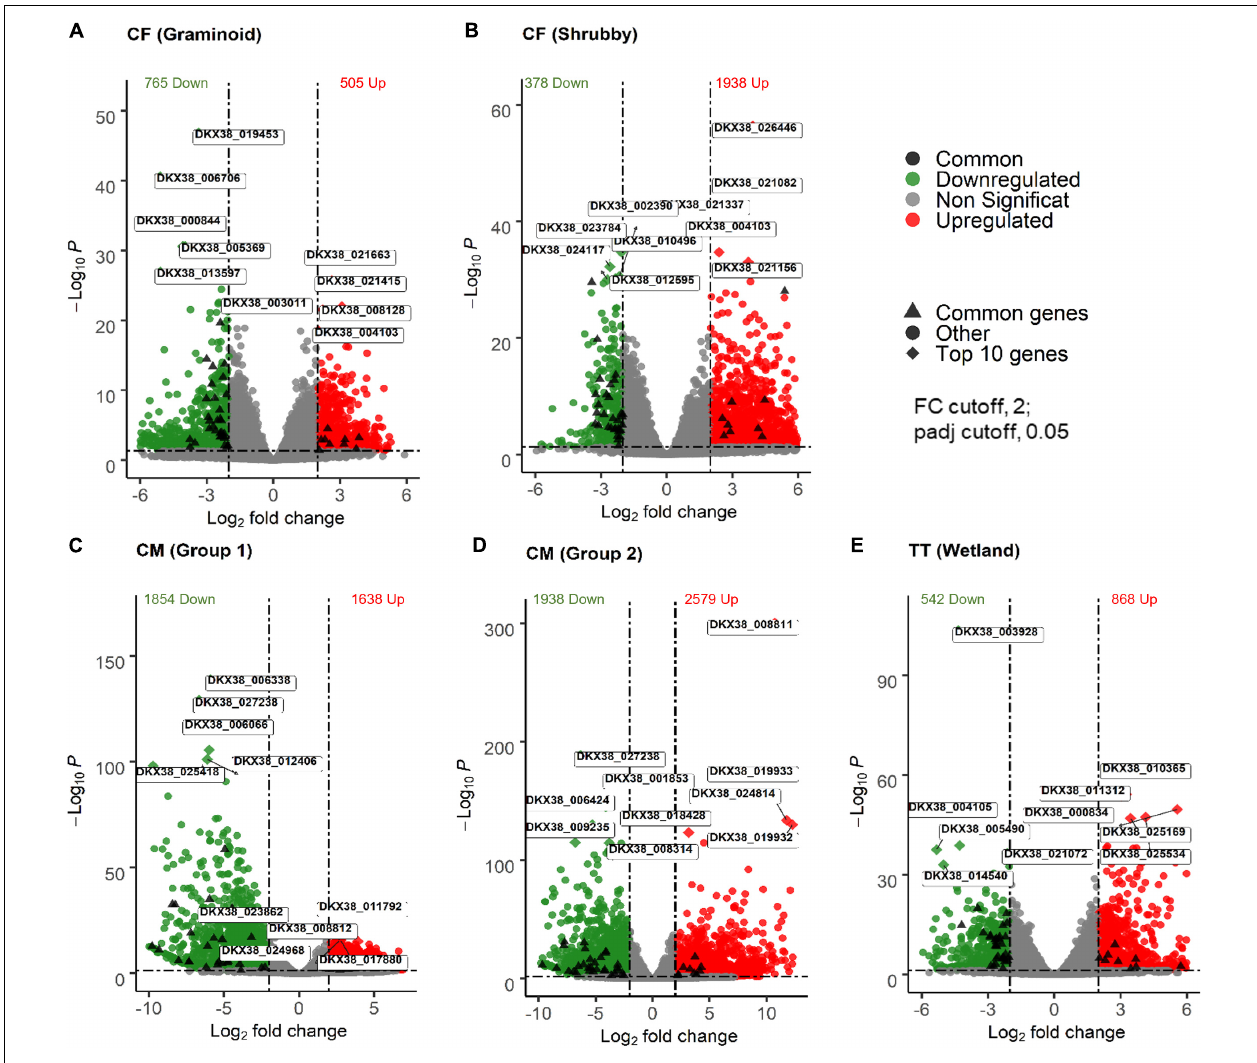
FIGURE 2 | Gene expression of willow exposed to different types of oil sands tailings (OST) stress. Willow grown on CF (with or without capping) along with graminoid (A) or shrubby (B) plant community. Willow grown along with graminoid fen community on CM with 5 cm capping compared to 90 cm capping (C) or 40 cm capping (D) . Willow grown on TT tailings (with or without capping) along with wetland plant community (E) . Volcano plots show the log transformed adjusted p -values of genes plotted on the y -axis and log 2 fold change values on the x -axis. Dotted line indicates cut-off of p -values and log2 fold change. Top 10 (5 upregulated and 5 downregulated) genes are labeled and functions of theses genes are shown in Figure 3 . FC, fold change; Padj, BH-adjusted p -values; CF, centrifuge tailings; CM, co-mix tailings; TT, thickened